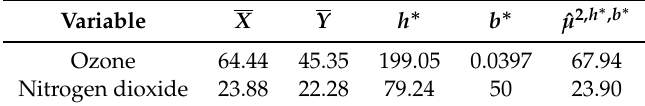
Table 2. Comparison of the full 15 years sample mean of the level of ozone and nitrogen dioxide with the mean of the analogous sample when the temperature is greater than or equal to 30 ◦ C and the proposed estimator ˆ µ for the values h ∗ and b ∗ obtained in the bootstrap